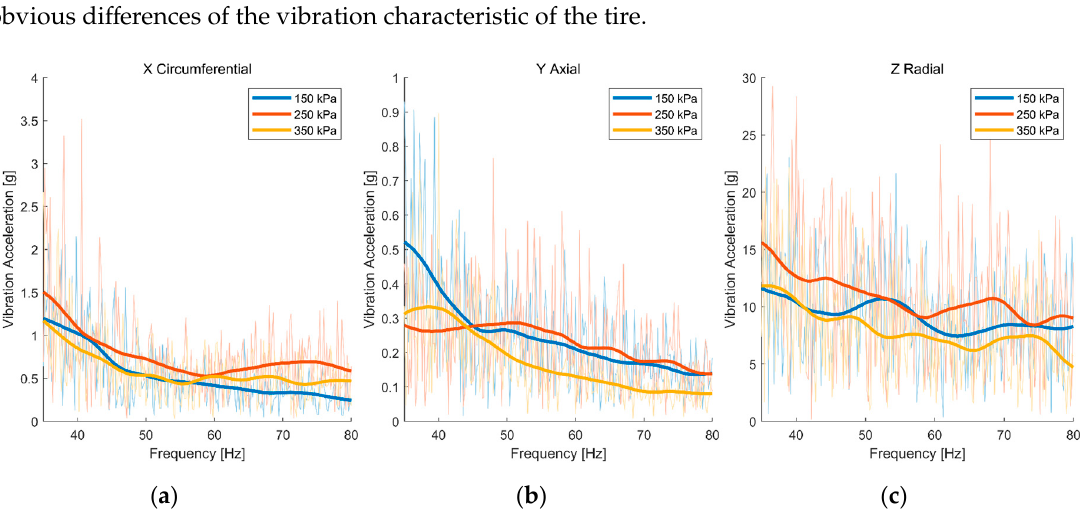
Figure 5. Amplitude-frequency curve of accelerometer A (tire tread) in three directions: ( a ) Circumferential direction; ( b ) axial direction; ( c ) radial direction.